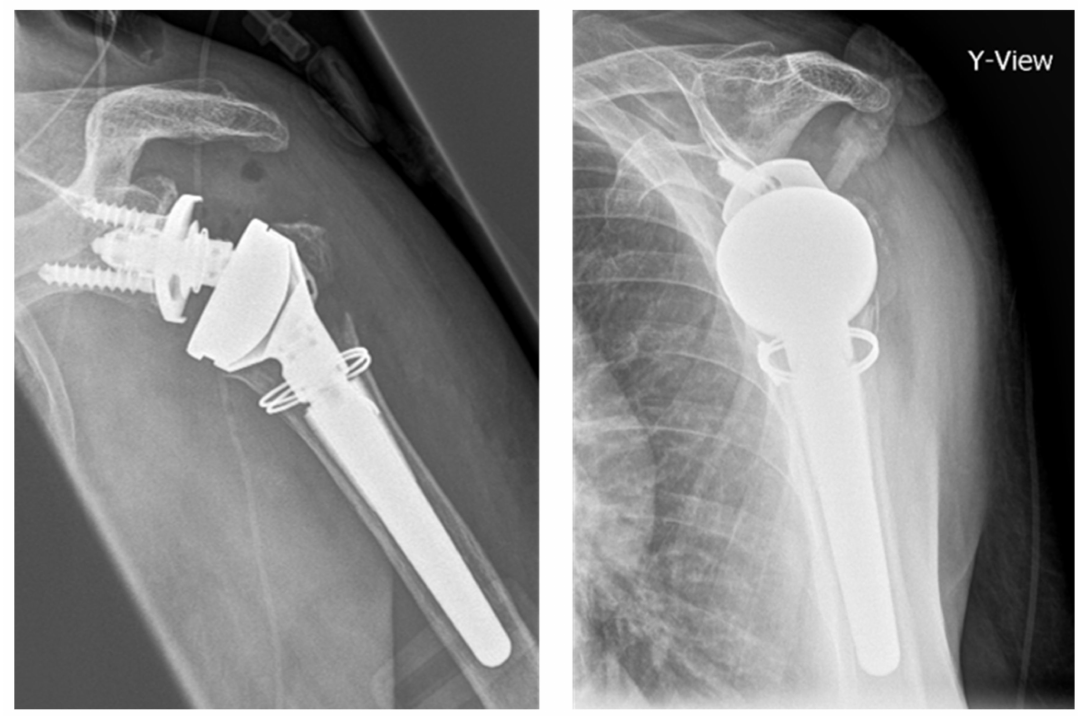
Figure 1. X-rays of the left shoulder of an 82 year-old patient after implantation of a modular, non-cemented proximal humeral fracture prosthesis (RSA) with protective cerclage (1.5 mm steel wire) at the metaphyseal